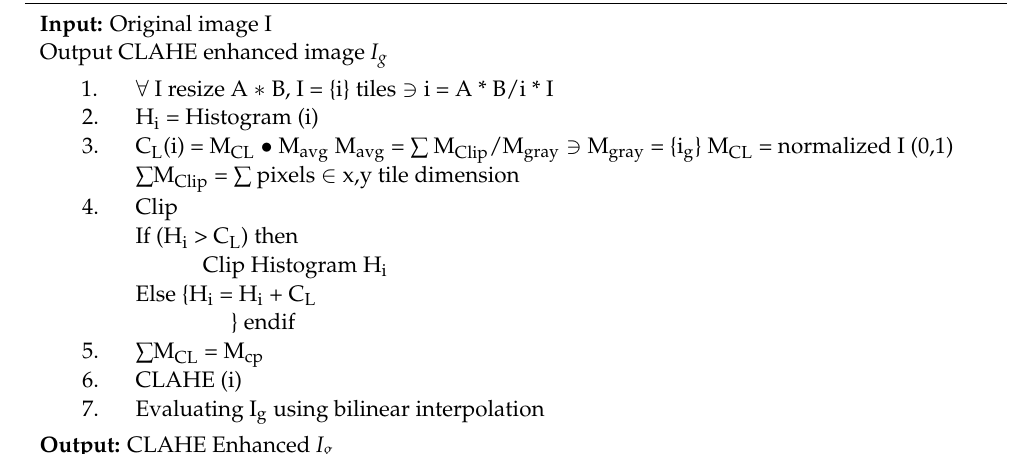
Algorithm 2: Algorithm of Adaptive